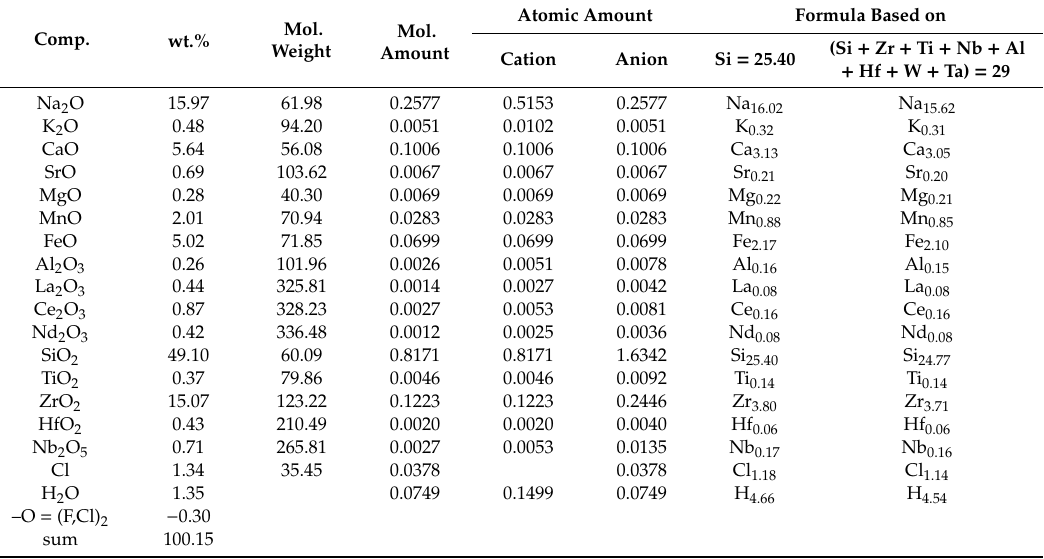
Table 4. The chemical composition and calculation of the formula of raslakite [24].